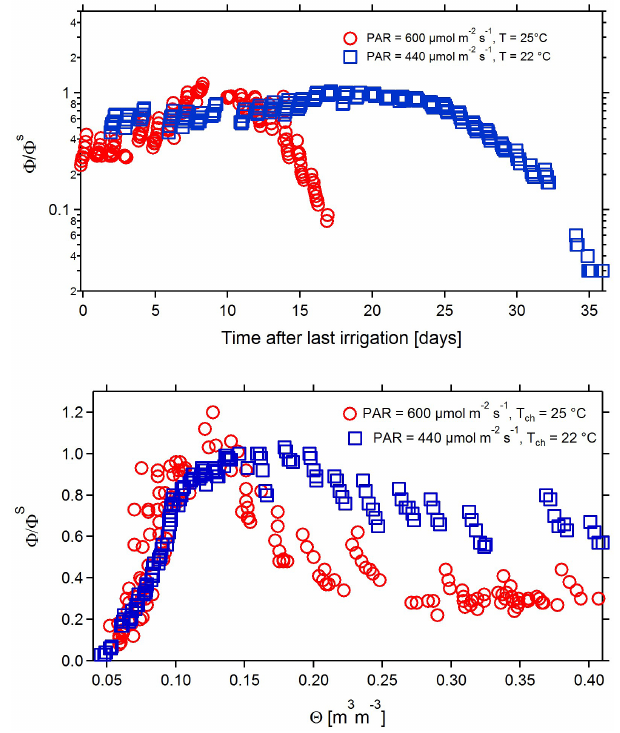
Figure 5. (a) Temporal shape of normalized α -pinene emissions from two individuals of Holm oak, experiments Holm oak 1 and Holm oak 2. Red circles show the data obtained at higher PAR and at higher chamber temperature. Blue squares show the data obtained for the plant investigated at lower temperature and PAR. Only data taken during periods of full illumination are shown. For better com- parison the emissions were separately normalized to the emission rates measured for the respective individual at (cid:50) ∼ 0.12m 3 × m − 3 . (b) Normalized α -pinene emissions from Holm oak in dependence of (cid:50) . Red circles show the data measured for the plant investigated at higher PAR and higher chamber temperature, blue squares show data taken for the plant investigated at lower PAR and lower tem- perature. Same data as in (a)